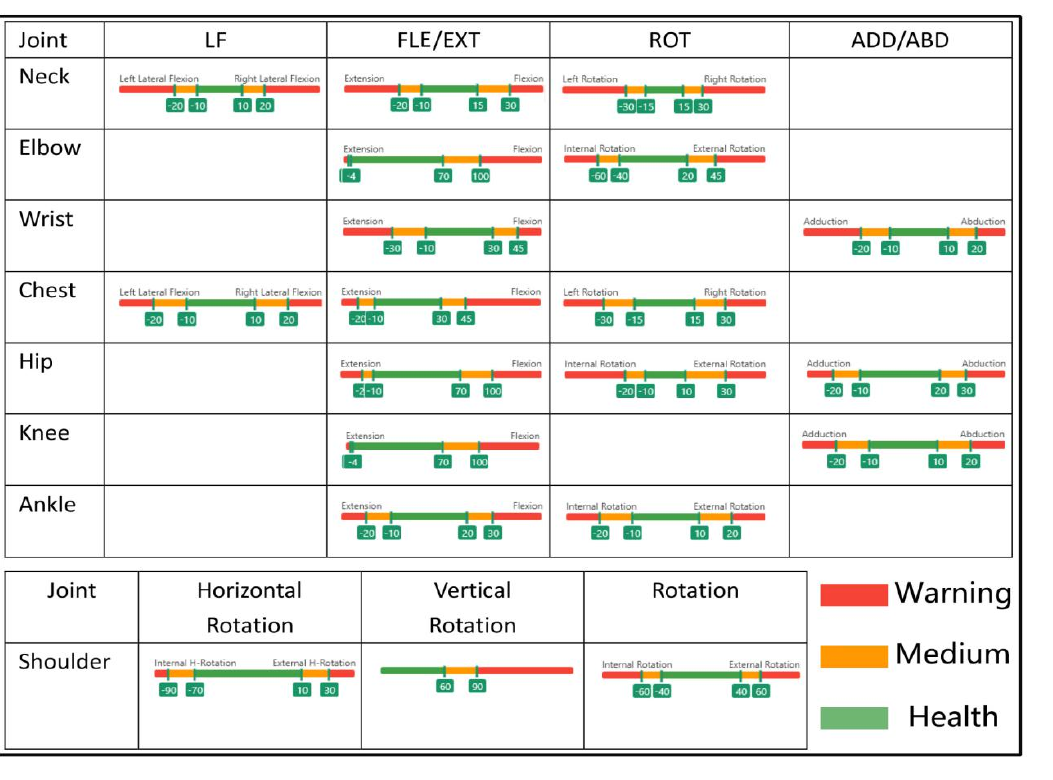
Figure 5. The threshold of joints. LF—lateral flexion; FLE—flexion; EXT—extension; ROT—rotation; ADD—adduction; ABD—abduction.